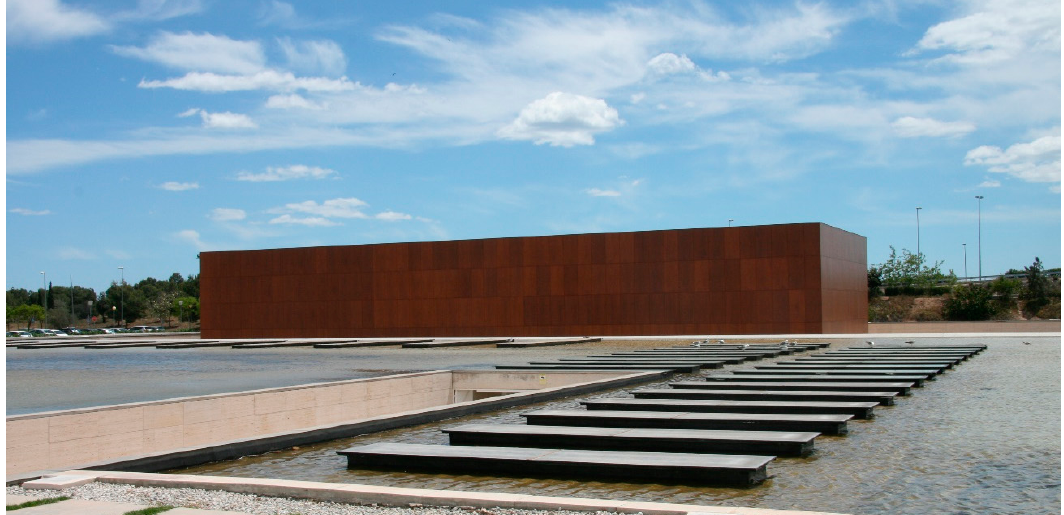
Figure 3. View of the Museum of the University of Alicante (MUA).